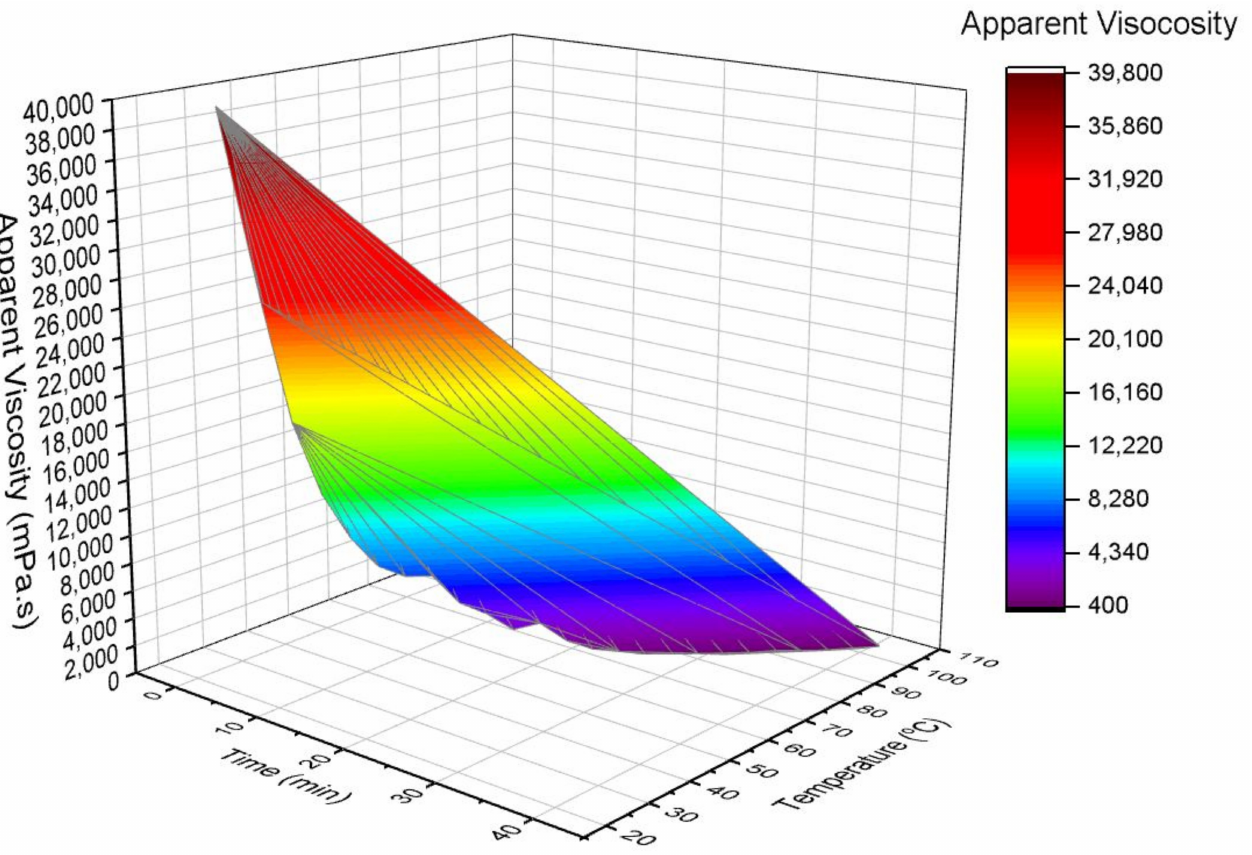
Figure 4. Surface 3D presentation of the effect of temperature and time on the apparent viscosity of Be:LA NADES